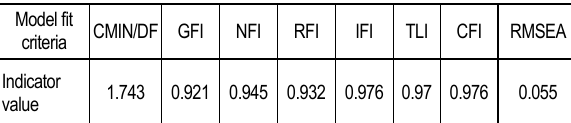
Table 2. Model fit results